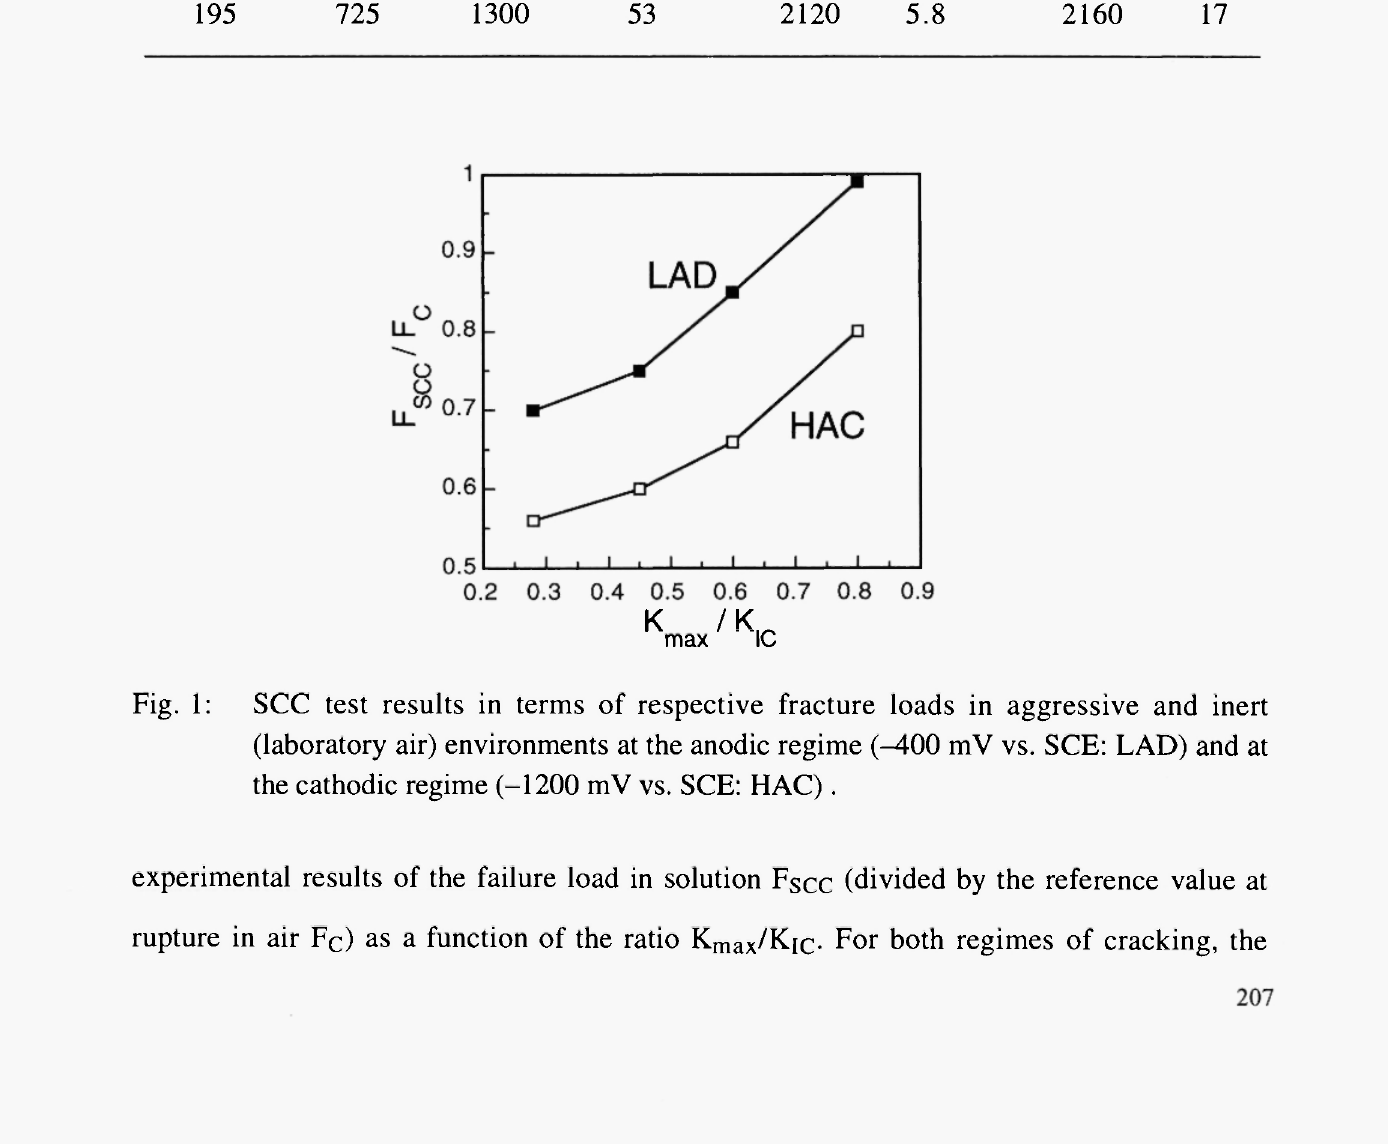
Young mod.Yield Stress